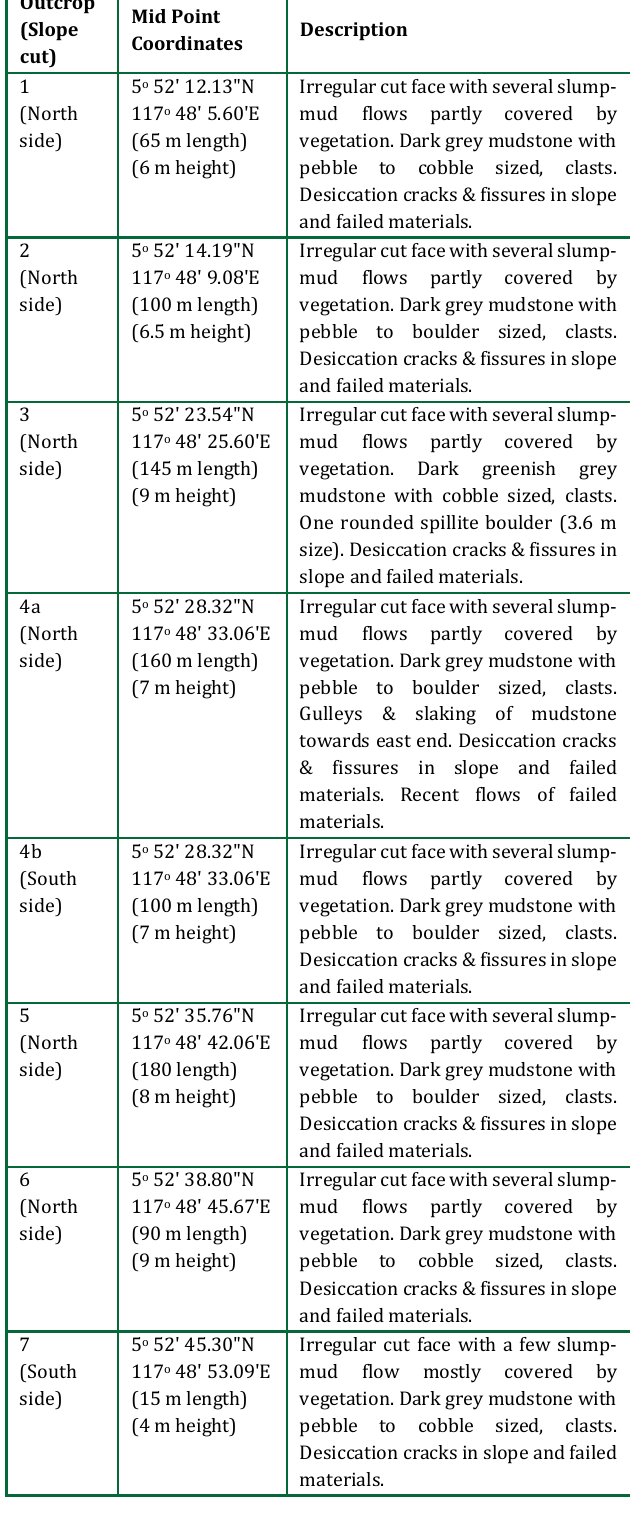
Table 1: Features of outcrops (slope cuts) along Jalan Sungai